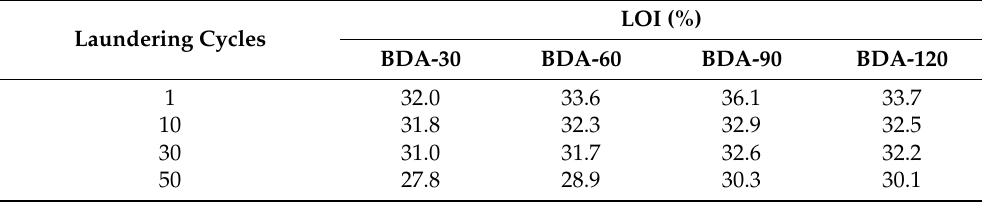
Figure 6. Heat release rate (HRR): ( a ) total heat release (THR); ( b ) curves of control sample and BDA treated samples. Table 3. The cone calorimeter test data of control sample and BDA-90-treated samples (3 curing times, 50 LCs).